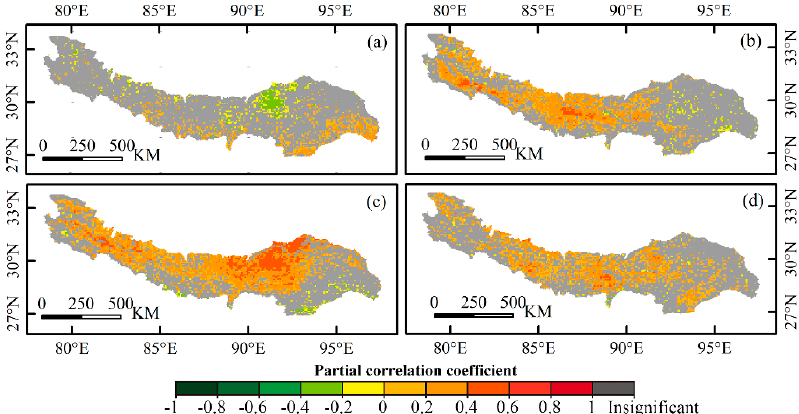
Figure 10. The spatial patterns of the main influencing factor on NDVI variations in summer, autumn, and the growing season.